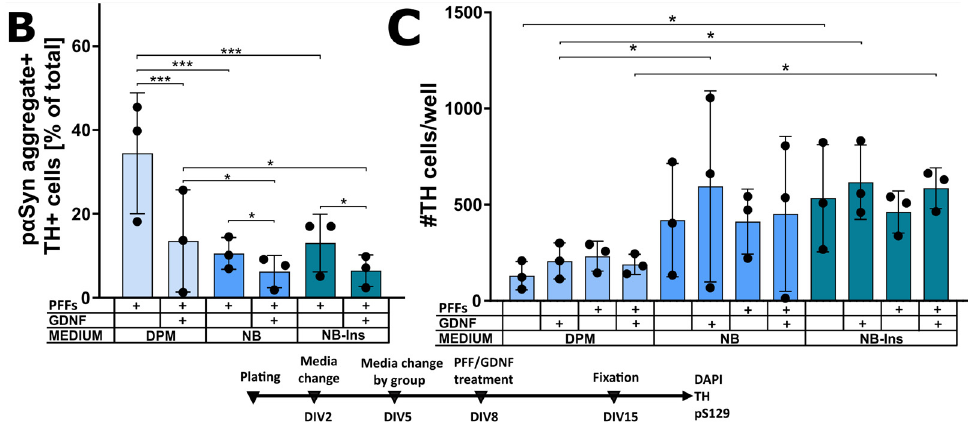
Figure 5. The effect of different culturing media (DPM, NB and NB-ins) on p α Syn aggregation in primary mouse embryonic dopaminergic neurons. ( A ) Representative images of control cells in DPM, NB and NB sans insulin (top), PFF-treated cells in DPM, NB and NB-ins (middle) and PFF- and GDNF-treated cells in DPM, NB and NB-ins. Scale bars 50 µm. ( B ) The effect of the media on the formation of intracellular LB-like inclusion in dopaminergic neurons of midbrain cell culture. ( C ) The number of TH-positive cells per well in correspondent media. n = 3 independent experiments, data are mean ± SD, *** p < 0.001, * p < 0.05.